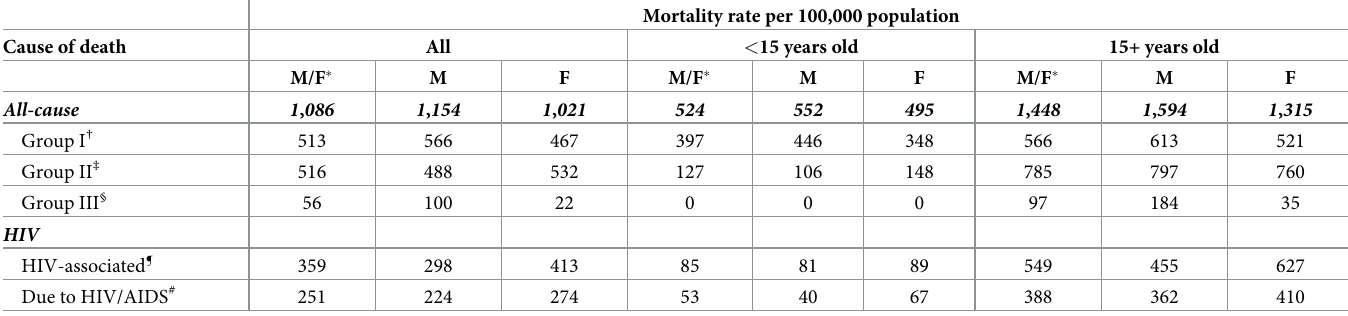
Table 5. Estimated all-cause and cause-specific mortality rates by GBD and HIV disease classifications in Kisumu County, Kenya